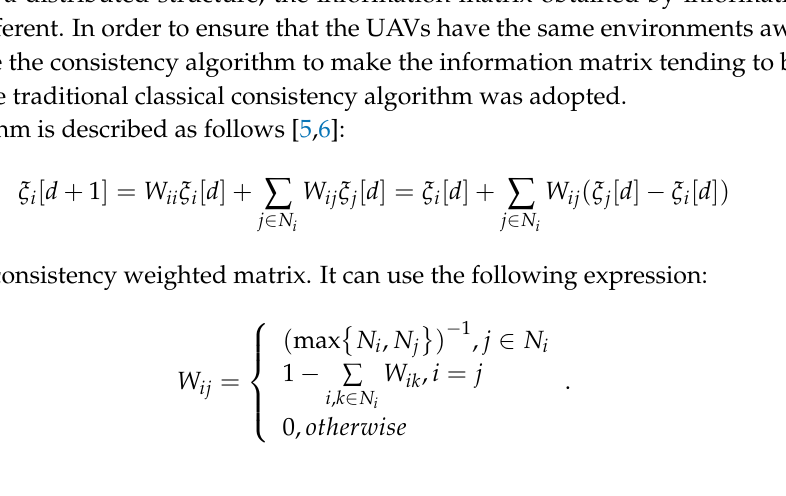
Figure 3. The observation configuration when N = 3.